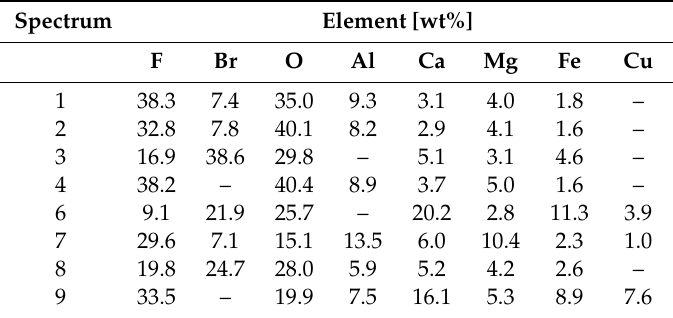
Figure 7. ( a ) SEM images of solid residue after digestion with US EPA method 3052; ( b ) chemical composition of specific particle surface material. Table 3. Results of surface analysis of selected sites and elements .